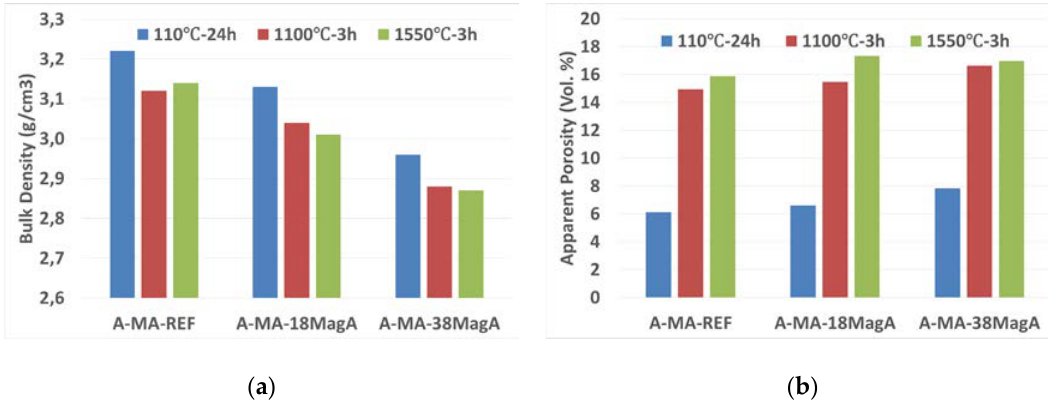
Figure 2. Bulk density ( a ) and apparent porosity ( b ) of castables after different heat